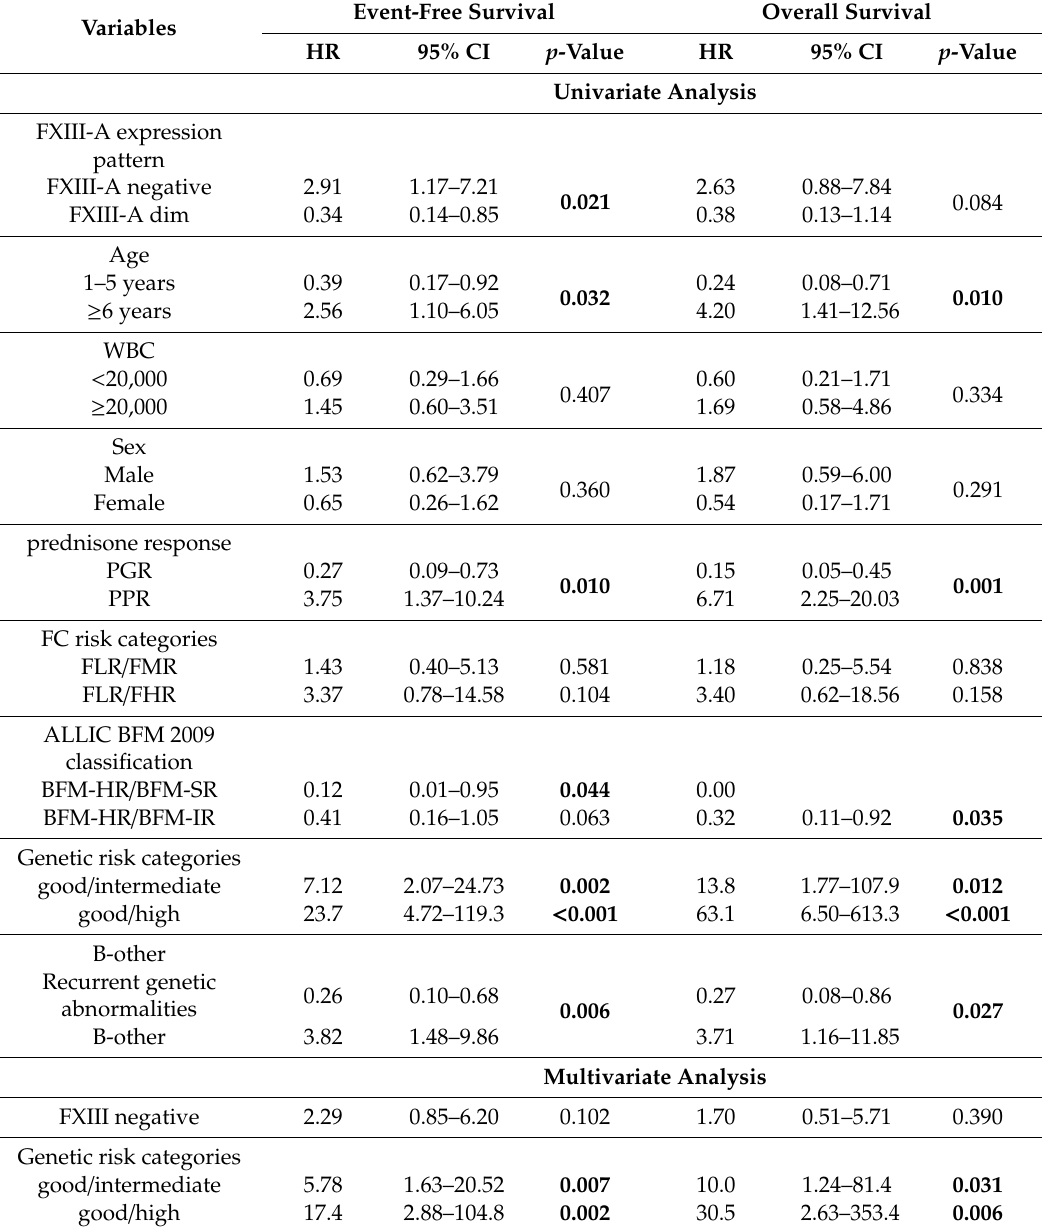
Table 1. Association of categorical variables on event-free survival (EFS) and OS of the FXIII-A negative vs. dim groups by univariate and multivariate Cox regression